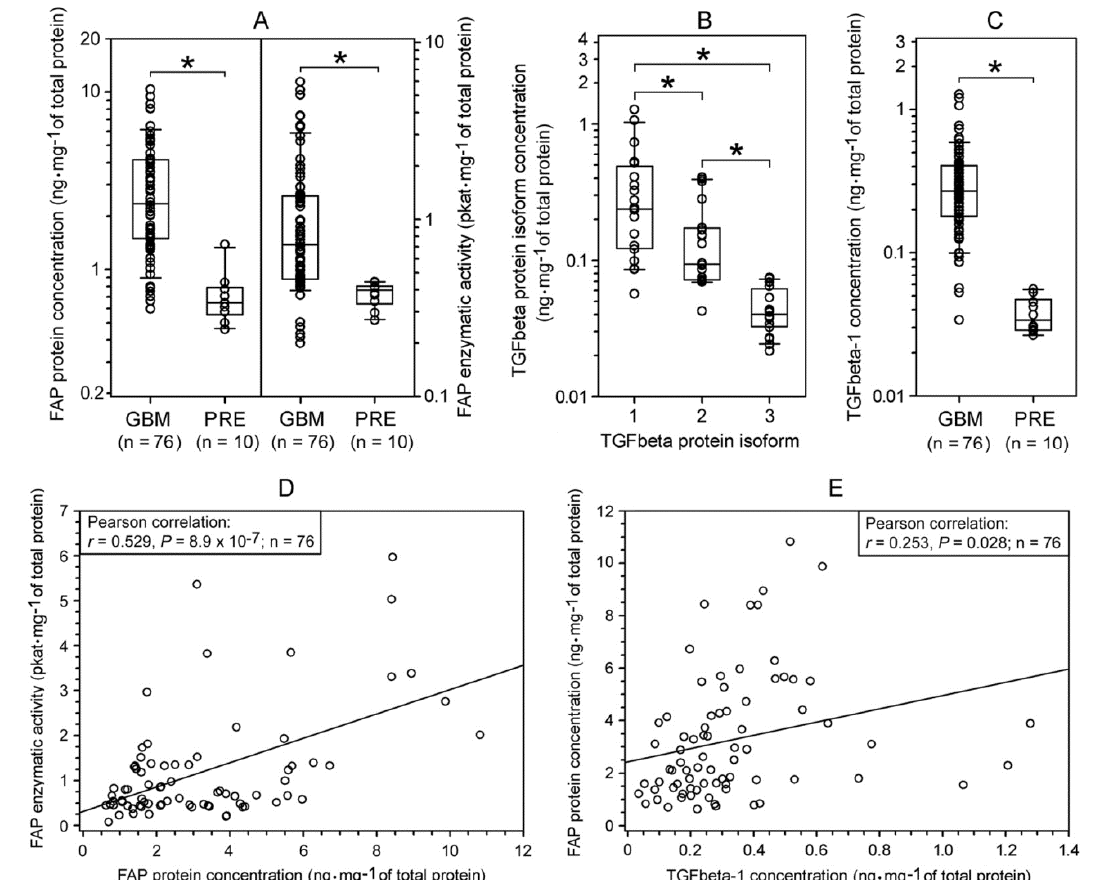
Figure 1. Expression of fibroblast activation protein (FAP) and transforming growth factor beta (TGFbeta) in human glioblastomas (GBMs). ( A ) Upregulation of FAP protein (left panel) and FAP enzymatic activity (right panel) levels in GBMs as compared to pharmacoresistant epilepsy (PRE) brain tissues. ( B ) Differential expression of TGFbeta protein isoforms in GBMs (n = 20). ( C ) Upregulation of TGFbeta-1 protein level in GBMs as compared to PRE brain tissues. ( D ) Relationship between the levels of FAP enzymatic activity and FAP protein in GBMs. ( E ) Relationship between FAP protein and TGFbeta-1 protein levels in GBMs. In ( A – C ), the sets of individual data points (each representing the mean of measurements in triplicate) are presented as a median with the box showing the 25th–75th percentile and whiskers indicating the 10th and 90th percentile. Note the logarithmic y-axis. In ( A , C ), * p < 0.01, Mann–Whitney rank sum test. In ( B ), * p < 0.05, Kruskal–Wallis one way ANOVA on ranks.